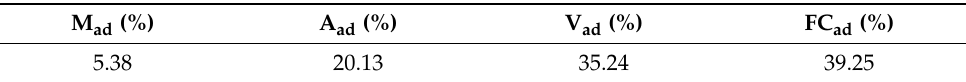
Table 1. Proximate analysis of coal sample (air dried).